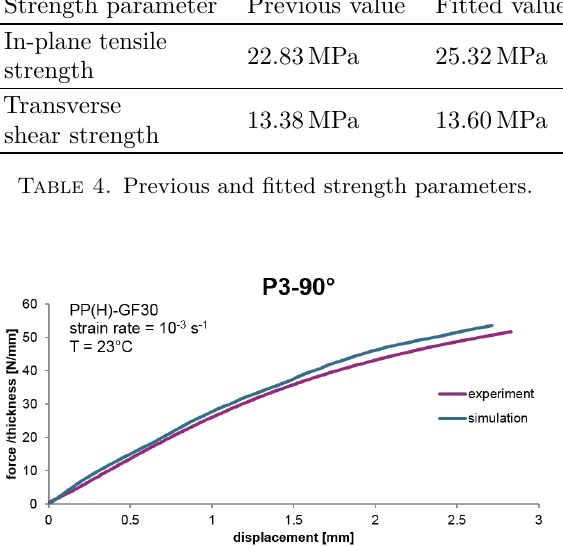
Figure 14. Comparison of force/thickness- displacement curves of experiment and simulation with fitted strength